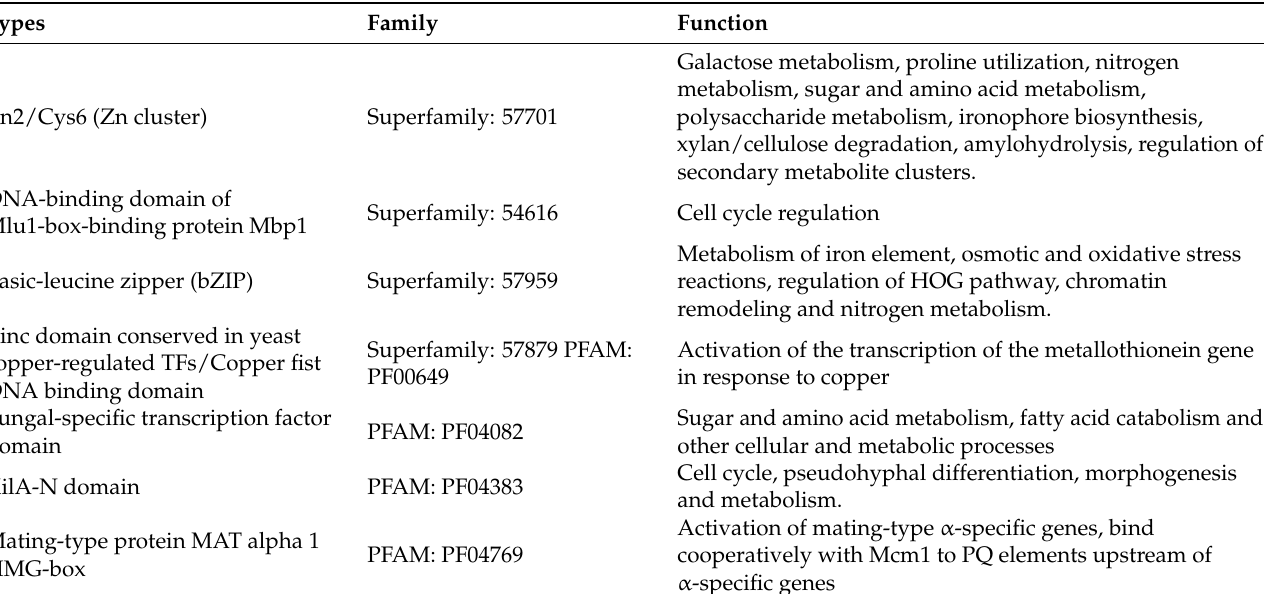
Figure 2. Distribution of PFAM families in different fungi. ( A ) A. melanogenum CBS110374; ( B ) A. pullulans EXF-150; ( C ) A. subglaciale EXF-2481; ( D ) A. namibiae CBS 147.97; ( E ) Aspergillus spp.: A. aculeatus , A. niger , A. fumigatis and A. oryzae RIB40; ( F ) S. cerevisiae : S. cerevisiae S288C, S. cerevisiae YJM244, S. cerevisiae YJM450, S. cerevisiae YJM993 and S. cerevisiae YJM1078. The average number of the regulators for each species is indicated underneath each pie chart. The number of genomes analyzed in all species is indicated in parentheses. Table 2. The Zn2Cys6 and fungal-specific TFs in Aureobasidium